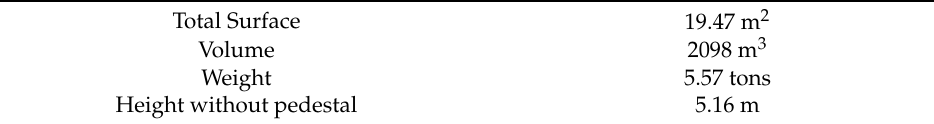
Table 1. David’s characteristics.